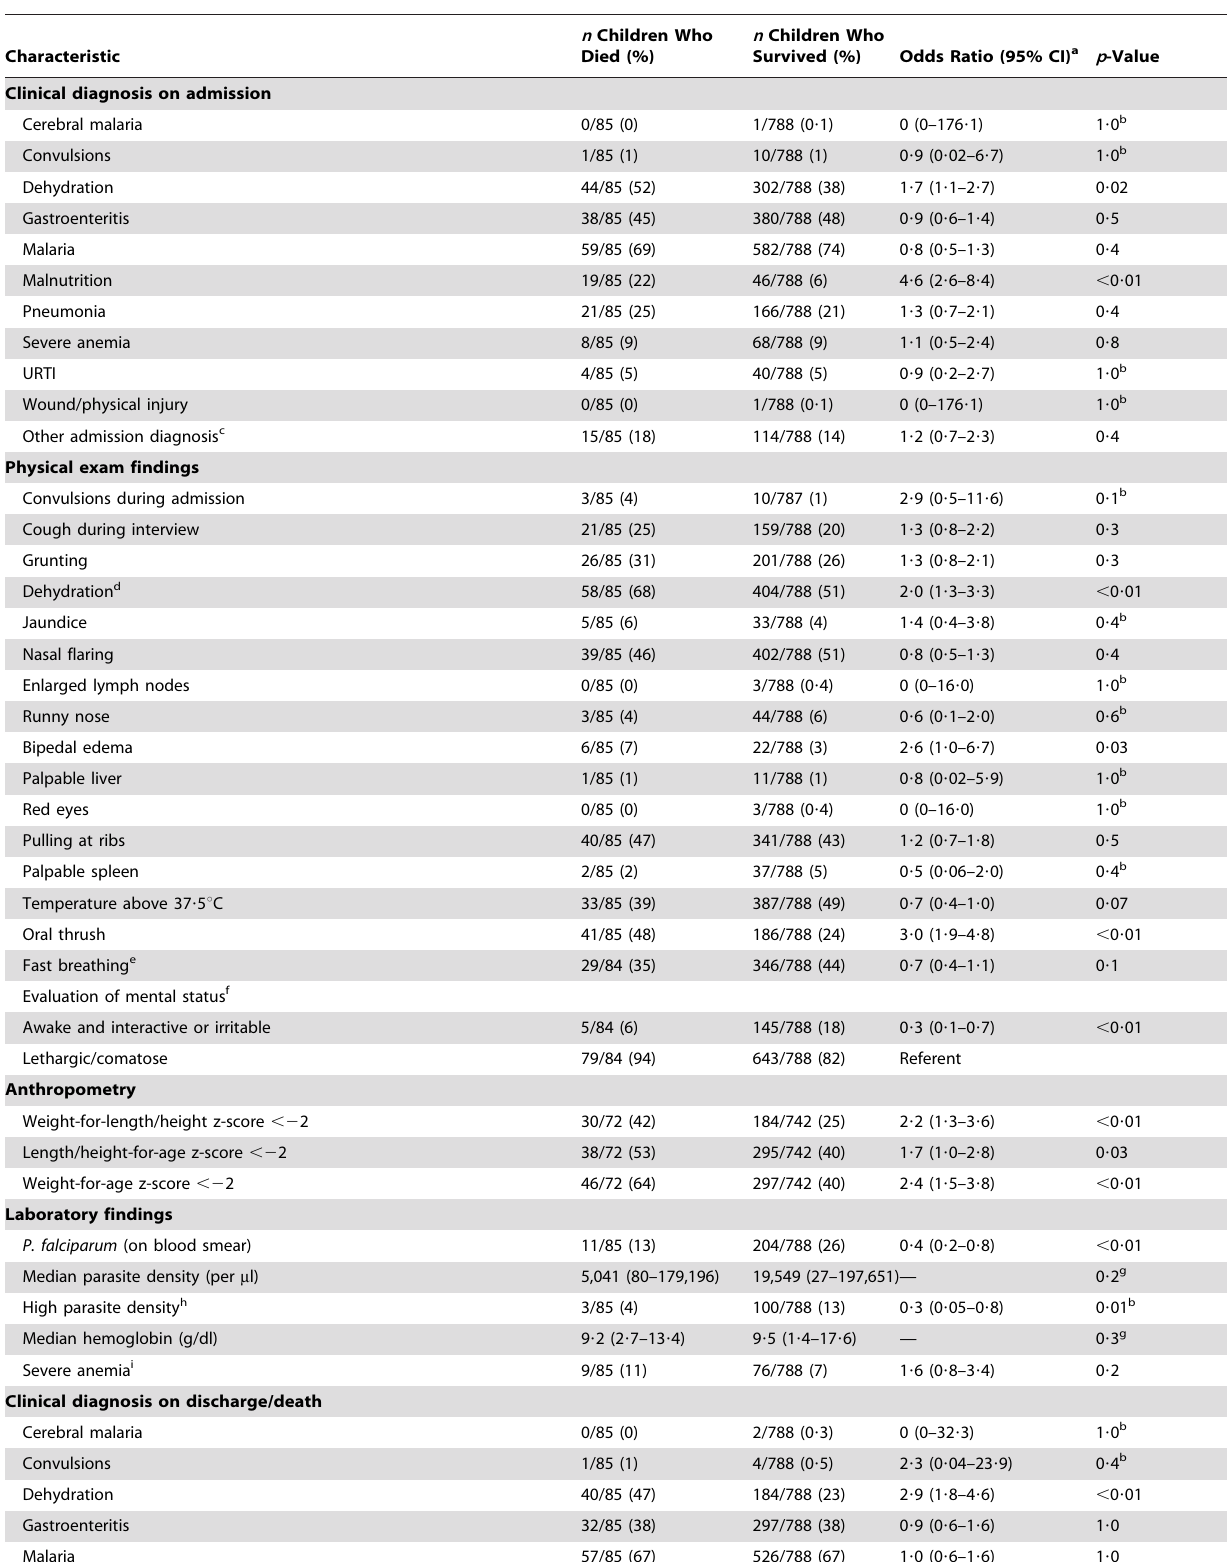
Table 4. Clinical information for children , 5 y old hospitalized with diarrhea in rural western Kenya (HDSS subset: 85 children who died, 788 children who